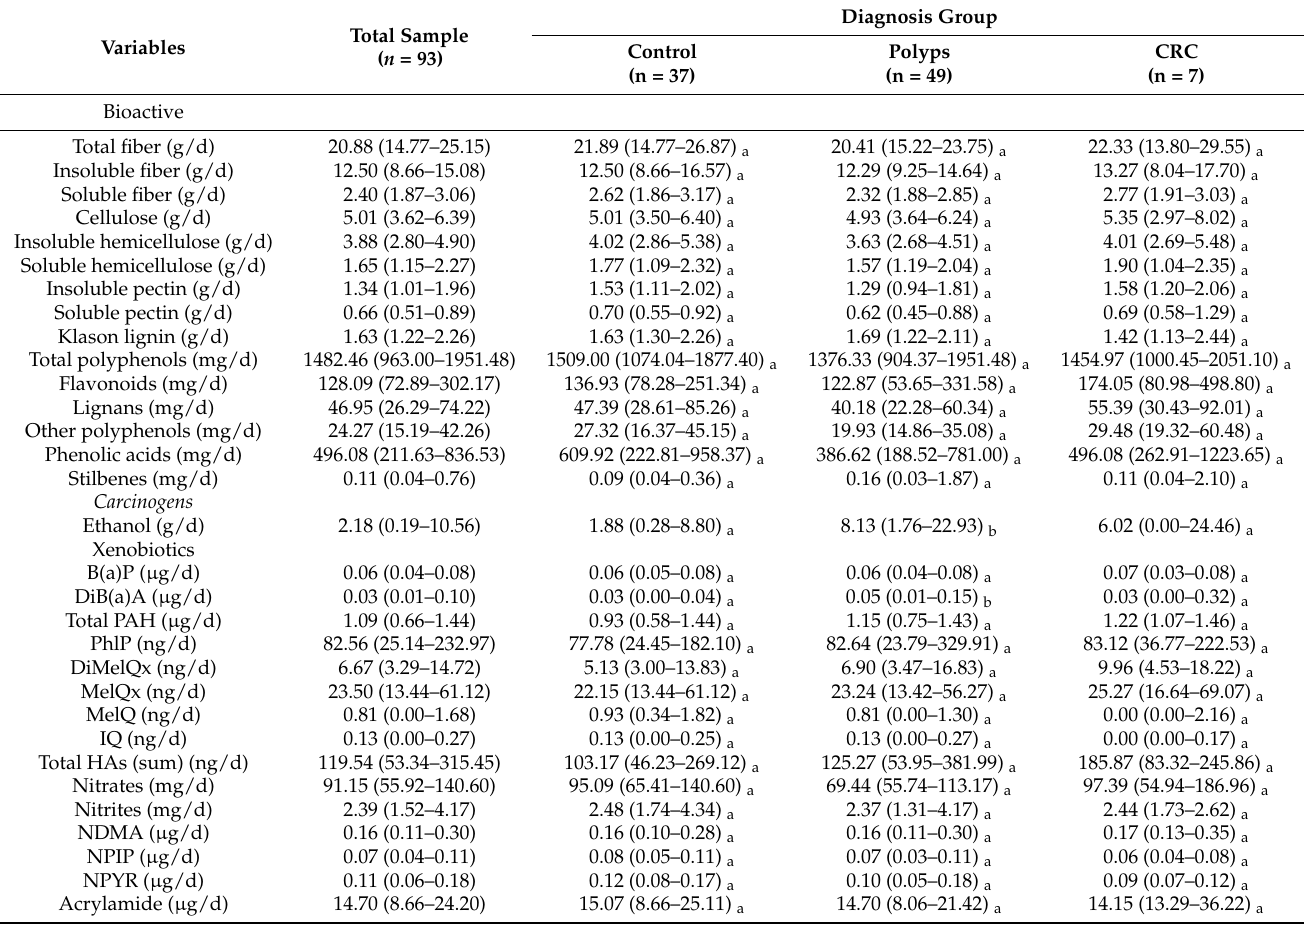
Table 2. Differences in the median intake of bioactive and carcinogenic compounds in the total sample and by diagnosis